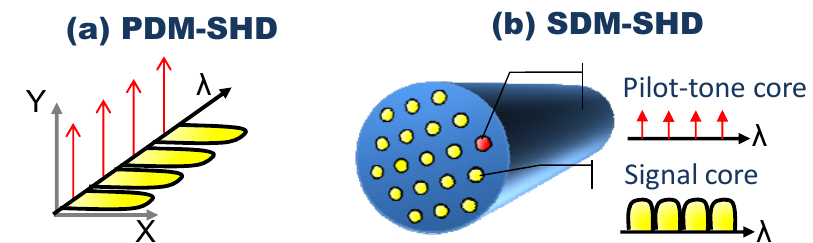
Figure 1. Signal and pilot-tone transmission schemes: ( a ) polarization-division-multiplexed (PDM) and ( b ) space-division-multiplexed (SDM) self-homodyne detection (SHD)